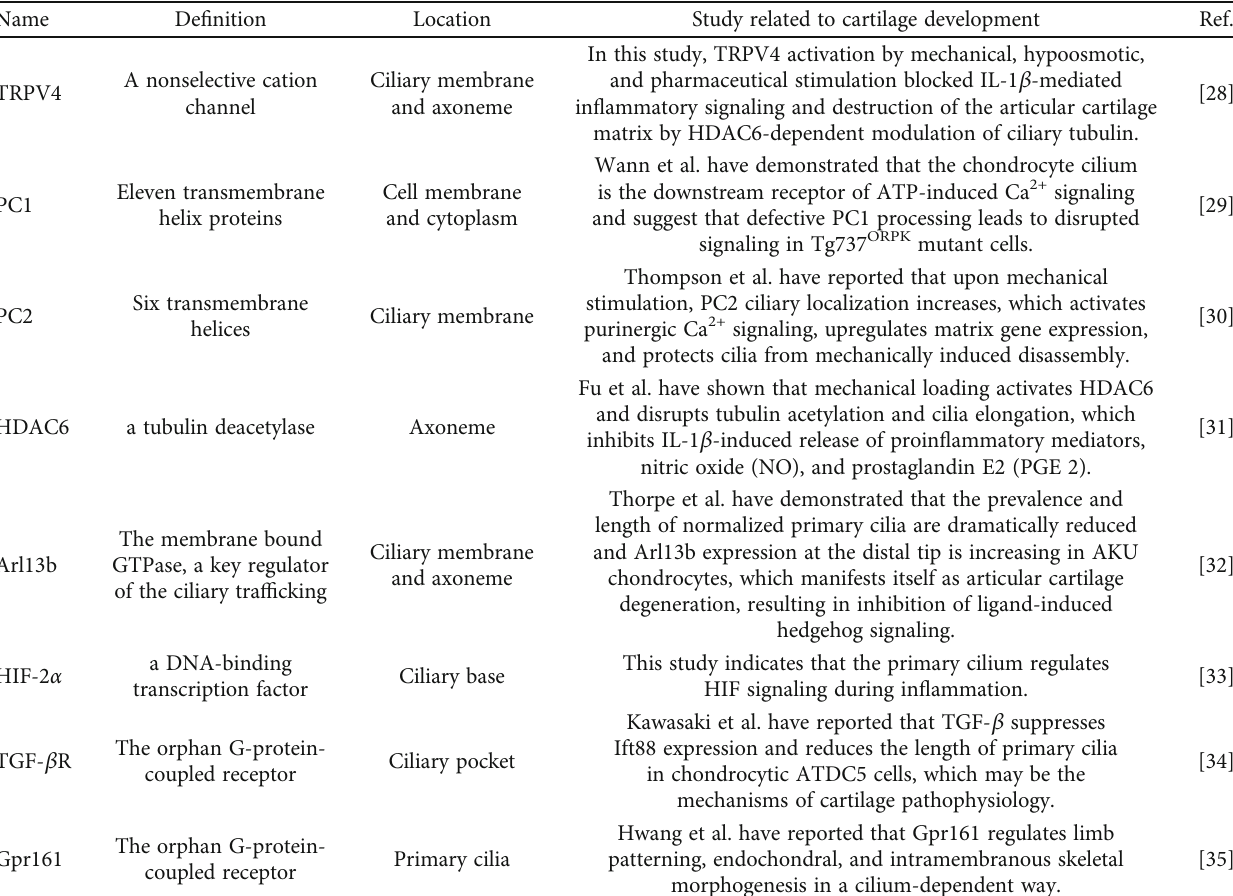
Table 1: The protein or signaling factors in the chondrocyte primary